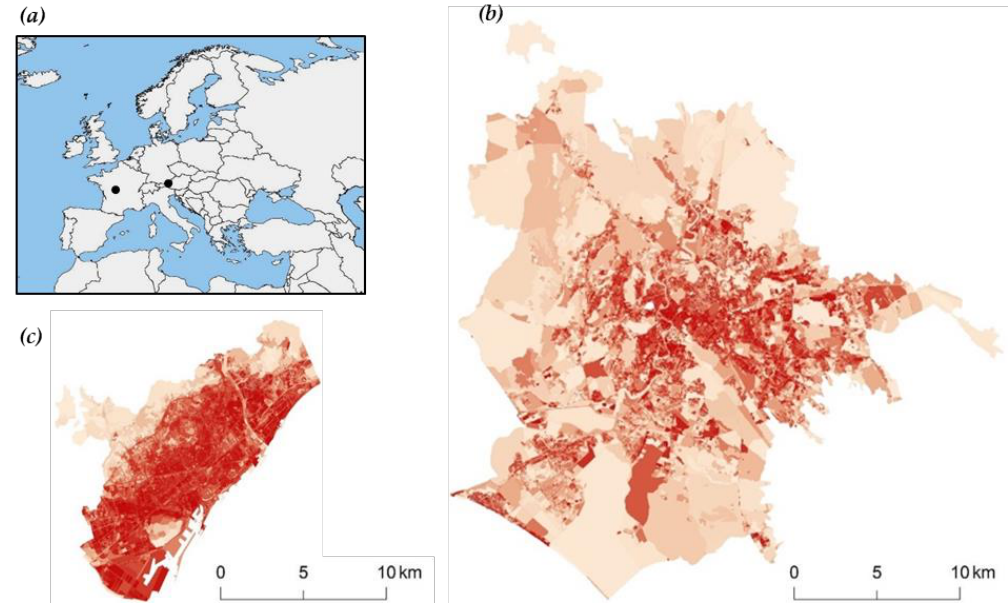
Figure 1. ( a ) Geographical location of the city of Rome in Italy and the city of Barcelona in Spain (black dots). Degree of soil sealing in ( b ) Rome and ( c ) Barcelona. More intense red tone indicates more intense soil sealing rate.